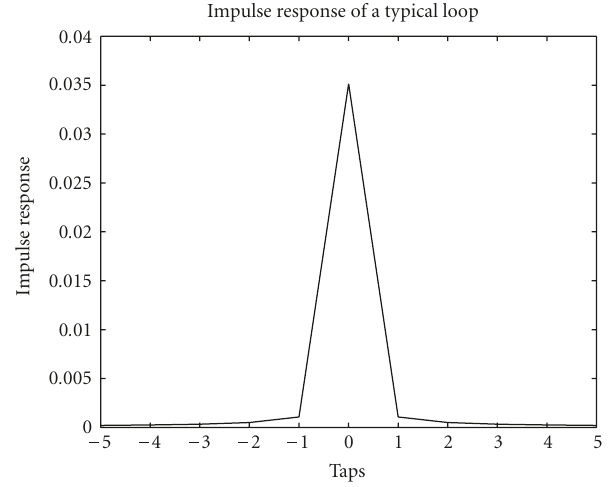
Figure 13: Impulse response of a typical end-to-end loop.